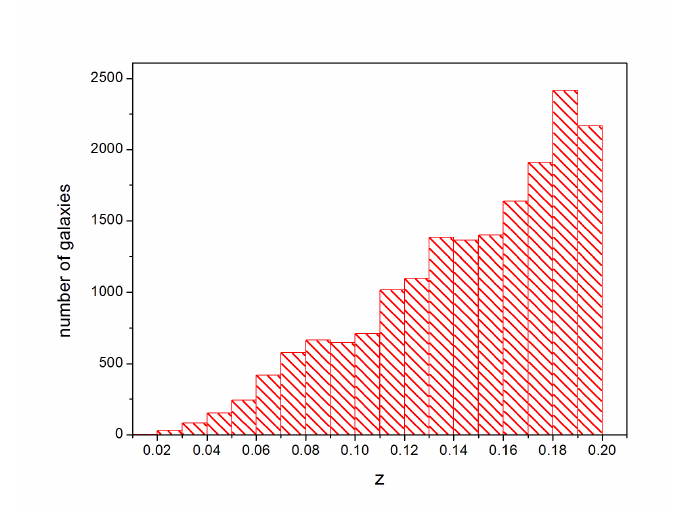
Fig. 2 BCGs distribution with their spectroscopic redshifts.